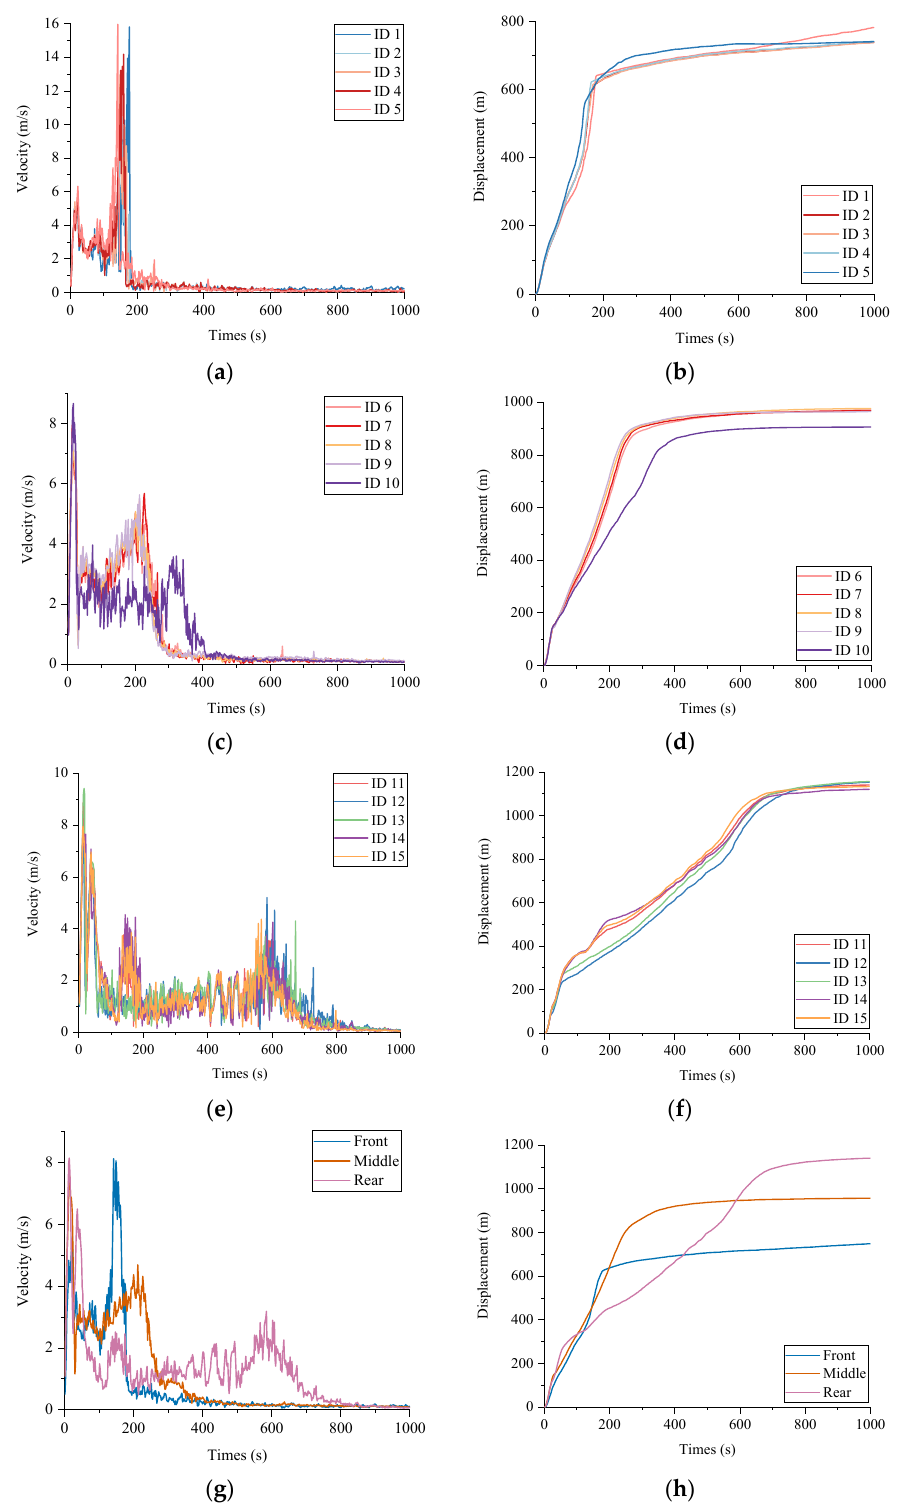
Figure 15. The velocity and displacement histories of the monitored particles: ( a ) velocity history of particle ID 1-5; ( b ) displacement history of particle ID 1-5; ( c ) velocity history of particle ID 6-10; ( d ) displacement history of particle ID 6-10; ( e ) velocity history of particle ID 11-15; ( f ) displacement history of particle ID 11-15; ( g ) velocity history of landslide front; ( f ) displacement history in the front, middle and rear parts; ( h ) velocity history in the front, middle and rear parts.